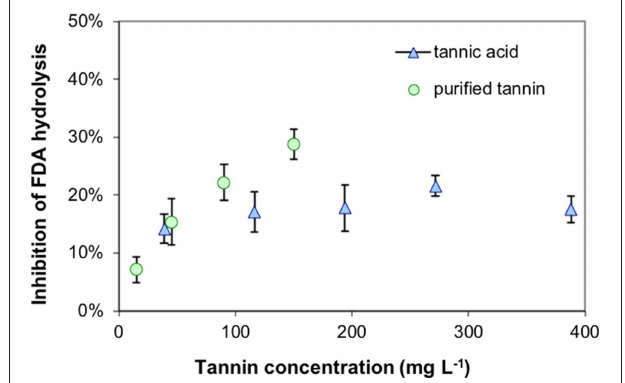
FIGURE 7 | Suppression of fluorescein diacetate (FDA) hydrolysis with increasing concentrations of tannins at the example of highly decomposed peat from rewetted peatland “Zarnekow” using commercial tannic acid and a isolated tannin of less decomposed peat from pristine peatland “Rzecin”.